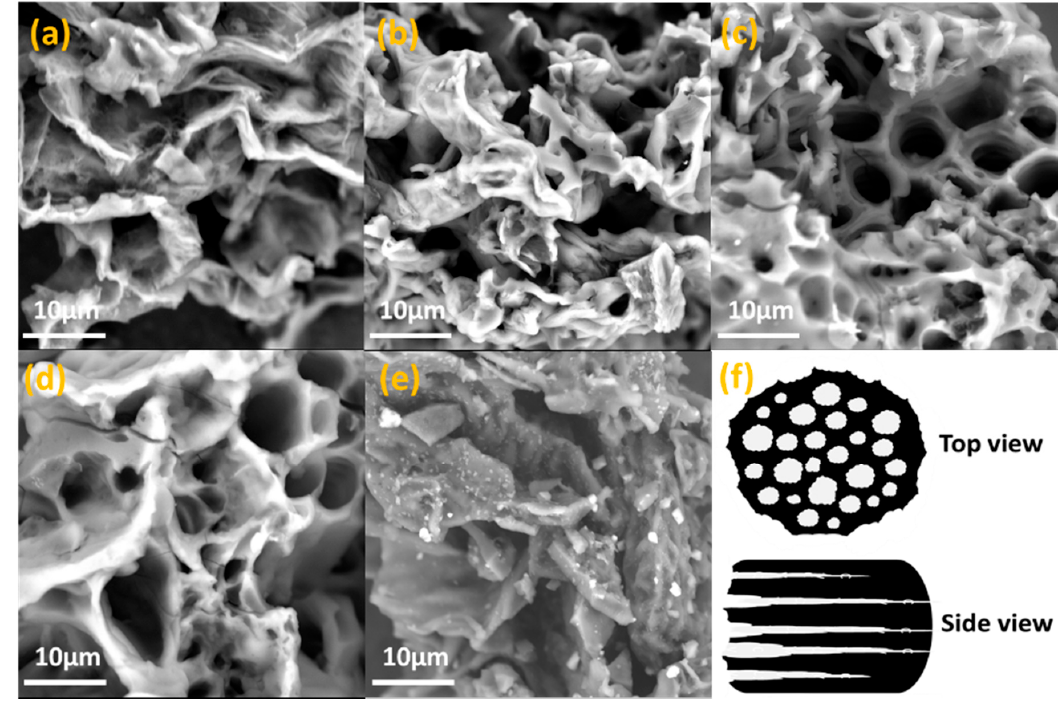
Figure 2. SEM image of ( a ) OPAC-0.5, ( b ) OPAC-1, ( C ) OPAC-2, ( d ) OPAC-3, ( e ) OPUAC, and ( f ) a schematic diagram of the porous structure in carbon derived from OP. schematic diagram of the porous structure in carbon derived from